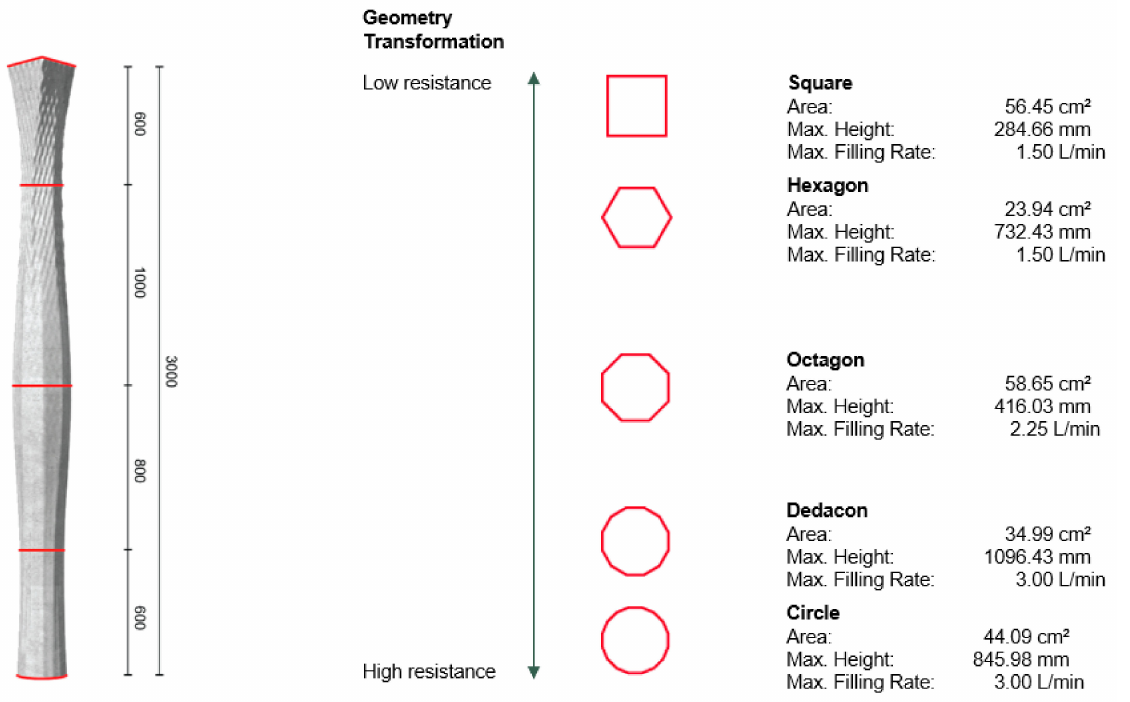
Figure 11. ( Left ) shows the column design intended for the experiment; ( right ) the five lofted geometries with their respective dimensions, volumes and intended filling